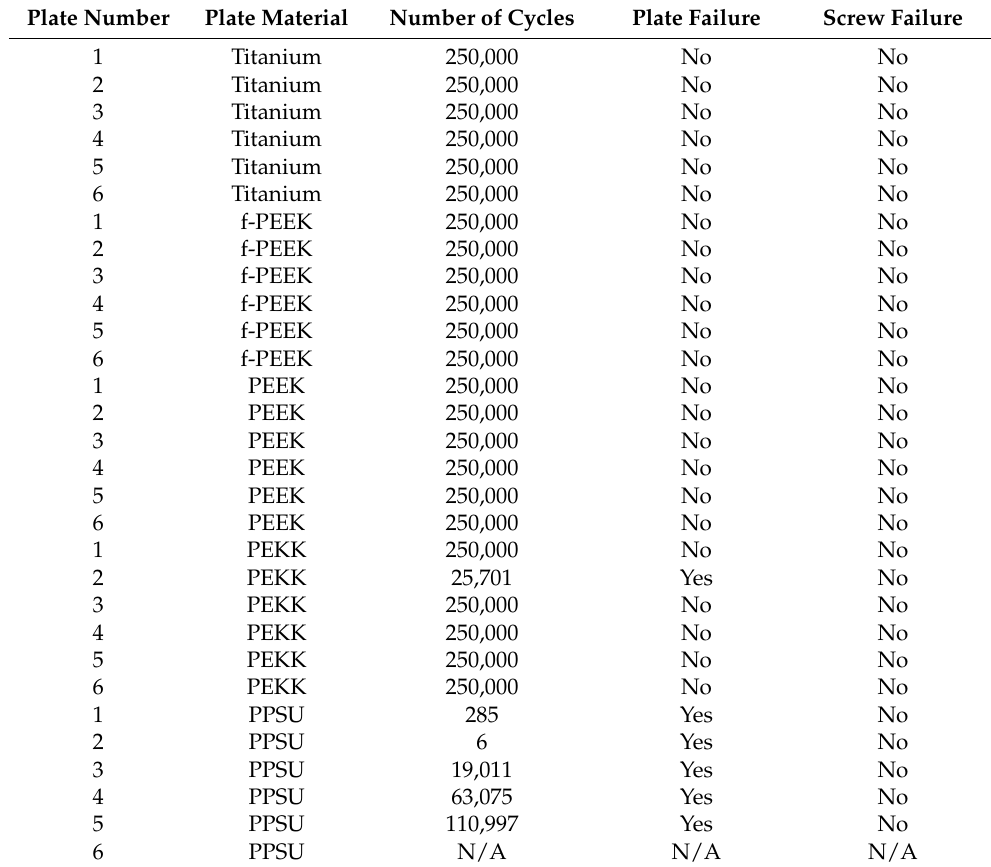
Table 2. Results of the fatigue test. N/A: Plate used in load to failure test.